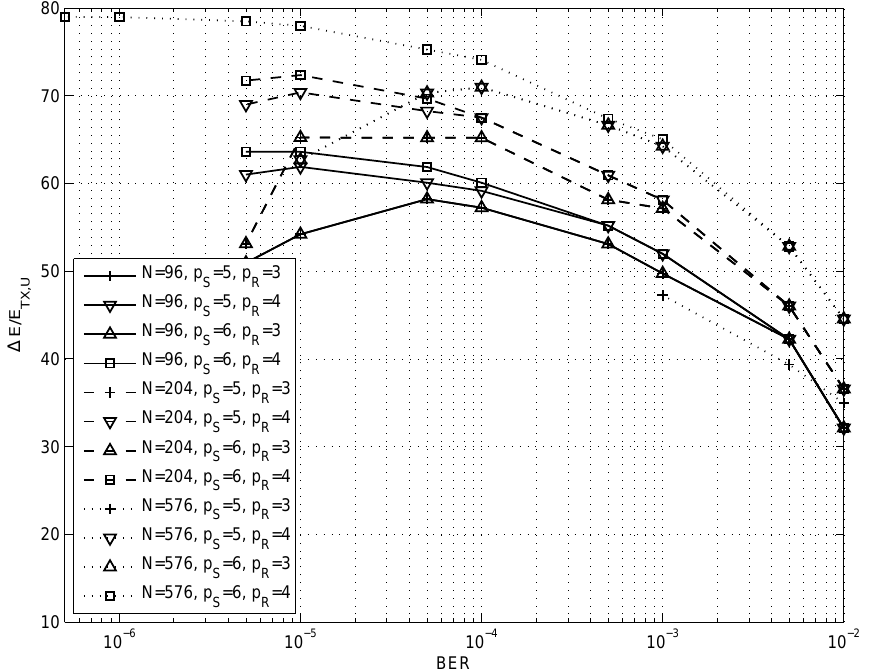
Figure 7. Percentage of energy per bit saved as a function of the BER for n = 4